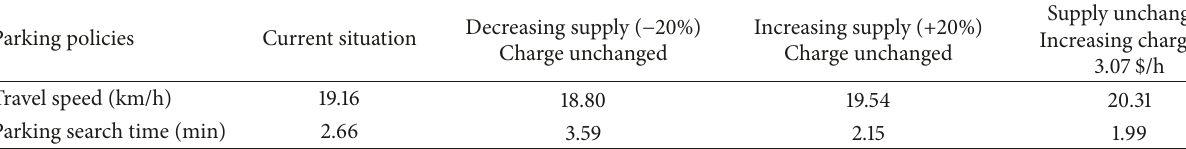
Table 4: Simulation of effect of different policies.